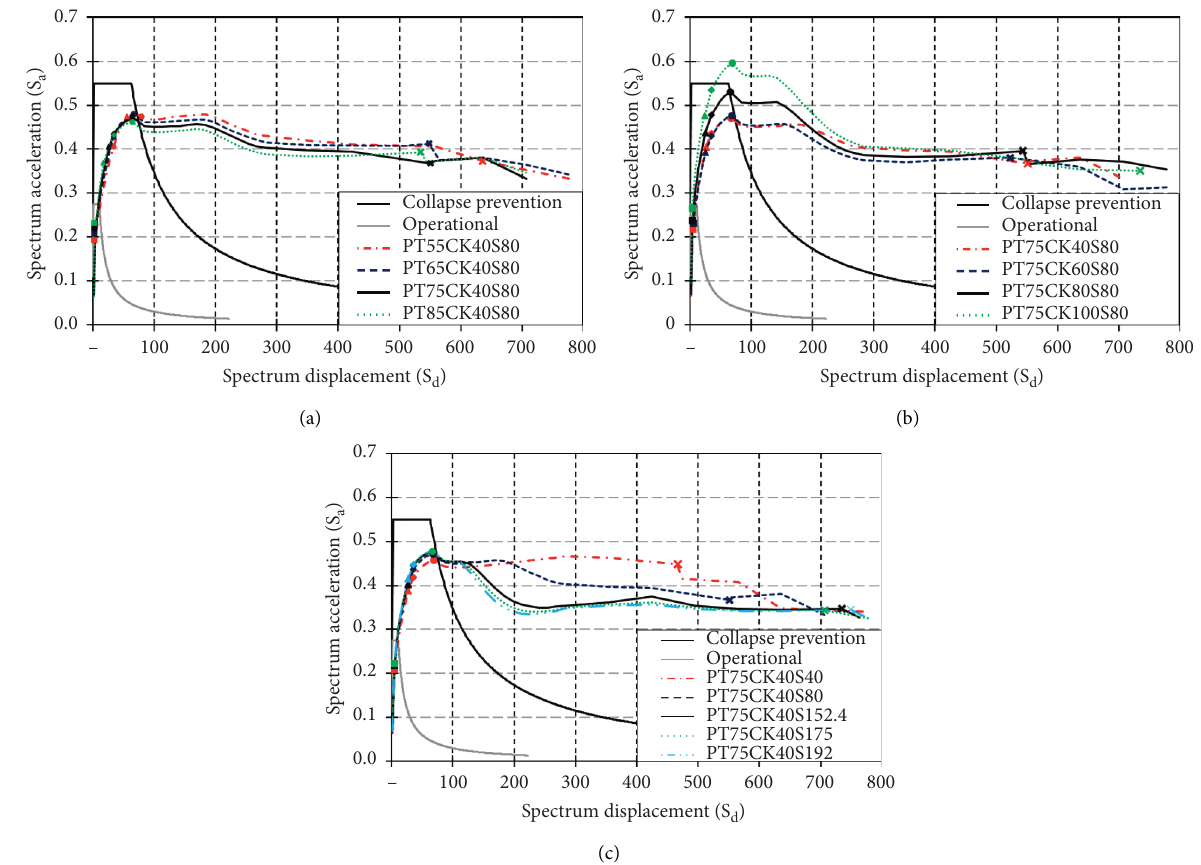
Figure 15: Parametric study of bridge piers. (a) Prestress. (b) Concrete strength. (c) Spacing of transverse